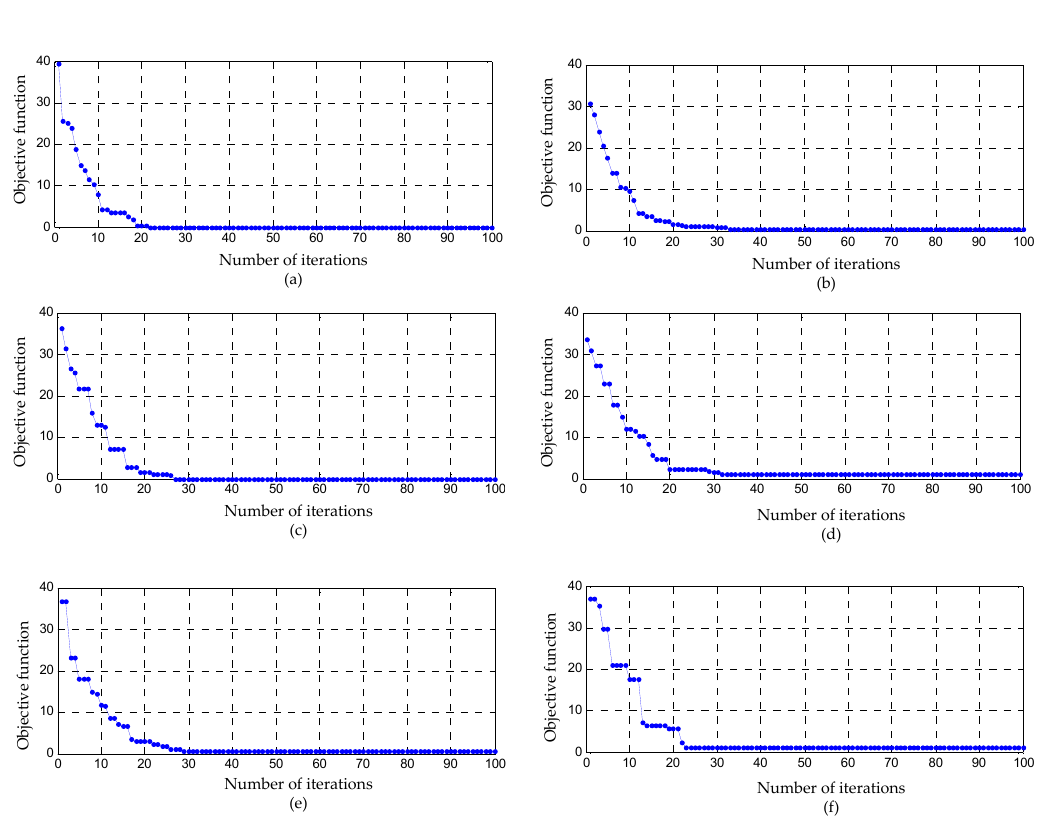
Figure 6. Convergence graphs of the iterative process of the cases in Table 1: ( a ) case 1; ( b ) case 2; ( c ) case 3; ( d ) case 4; ( e ) case 5; ( f ) case 6.